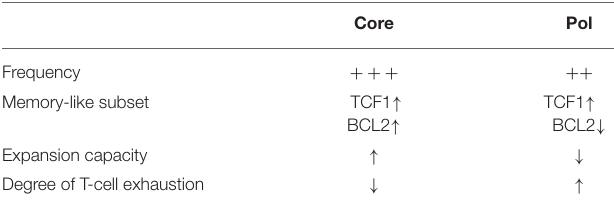
TABLE 1 | Different facets of exhausted HBV-specific CD8 + T cells targeting different